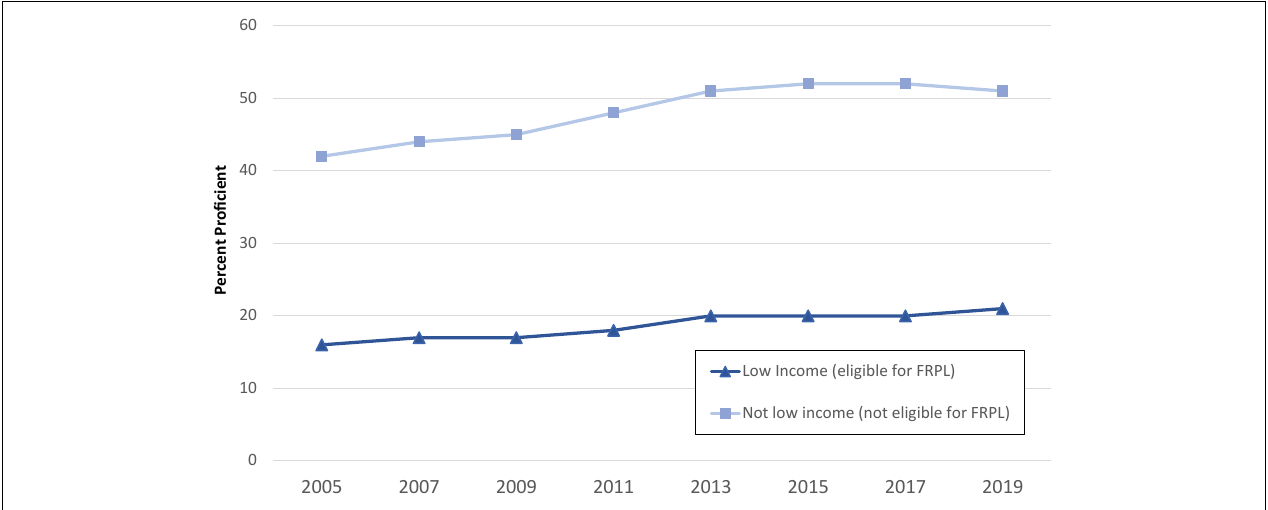
FIGURE 1 | Reading proficiency of United States 4th graders by year and family income status. Percent proficient refers to students who met or exceed the reading proficiency threshold in the National Assessment of Educational Progress (NAEP) by eligibility for free or reduced price lunch subsidy, an indicator of low-income